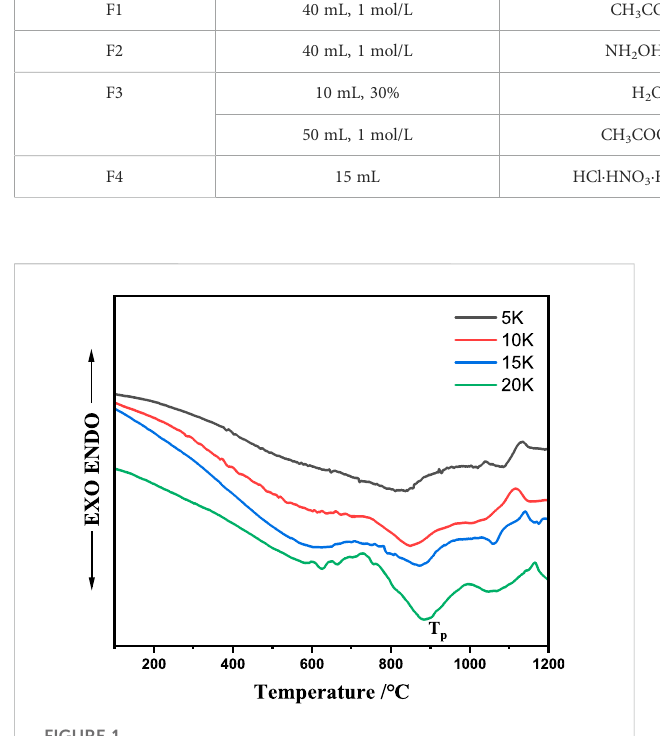
FIGURE 1 The DSC curves of the fl y ash-slag-based parent-glass samples with different heating rate ranging from 100 ° C to 1,000 ° C/min: 5 ° C/min, 10 ° C/min, 15 ° C/min, and 20 ° C/min.